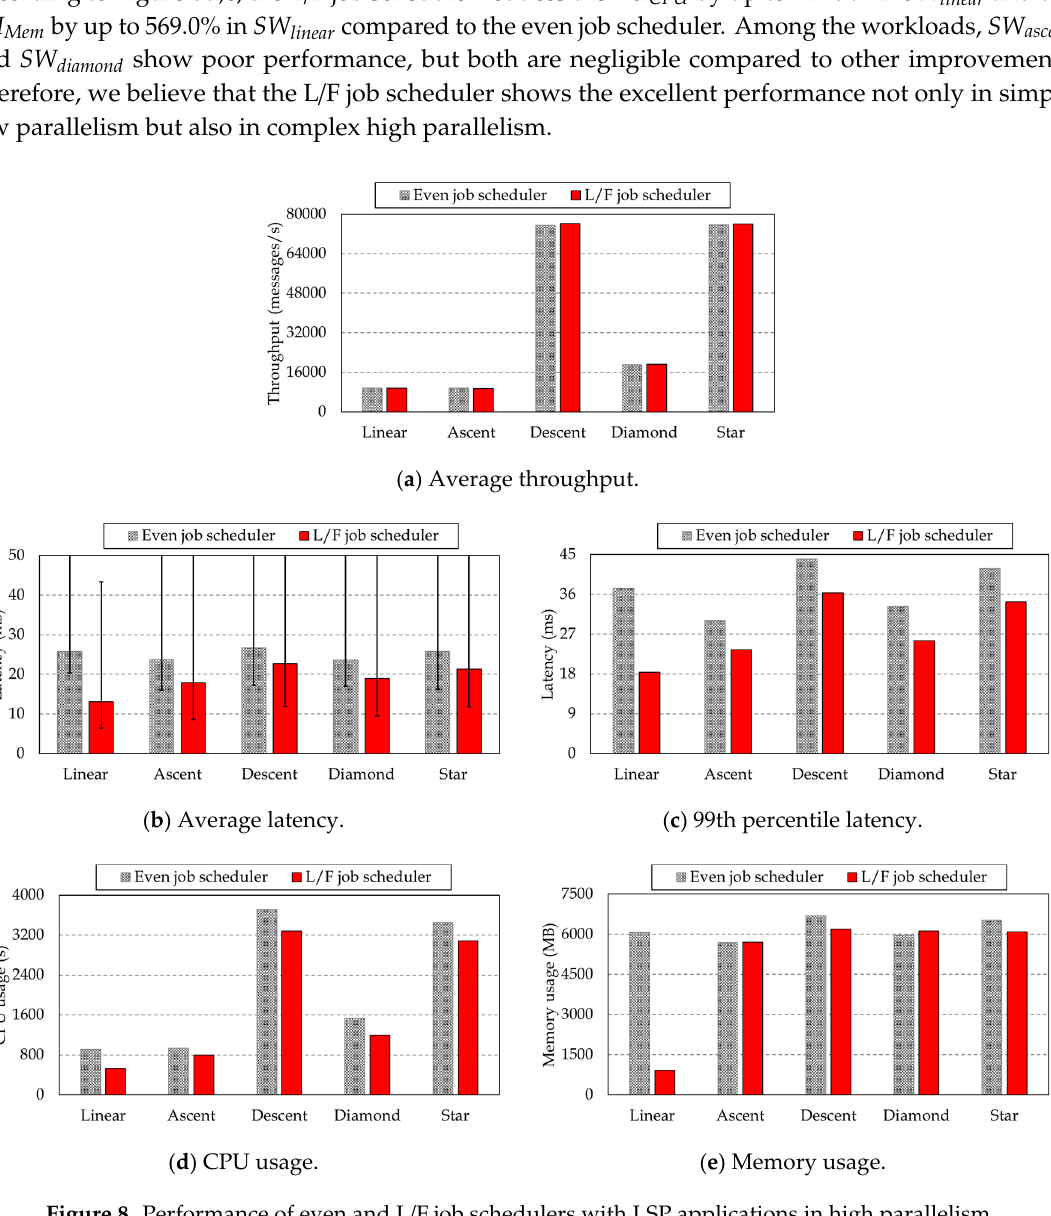
Figure 8. Performance of even and L/F job schedulers with LSP applications in high parallelism.